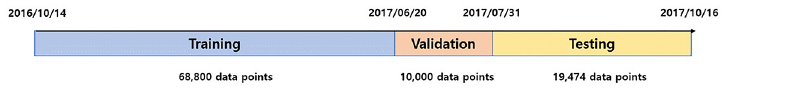
Fig 1. Setting training, validation and testing dataset during the whole sample period.